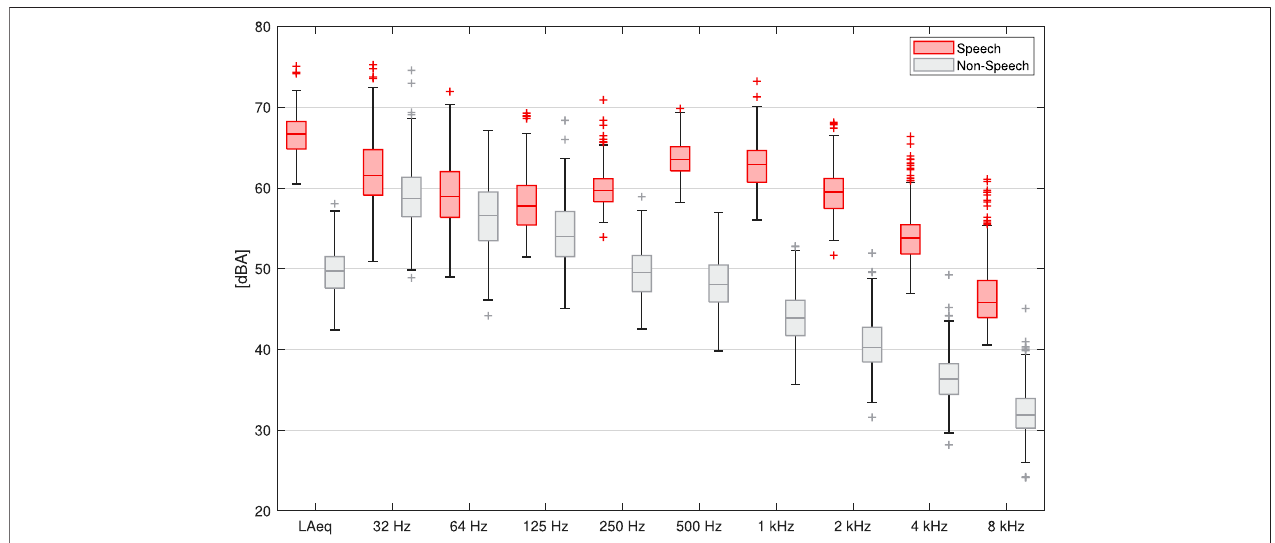
FIGURE6| Boxplotsofthespectraacrossthetwodataclustersobtainedfromk-meansclustering,demonstratingthatoneclusterincludesthosedatawithhigher levels in speech frequencies while the other does not.